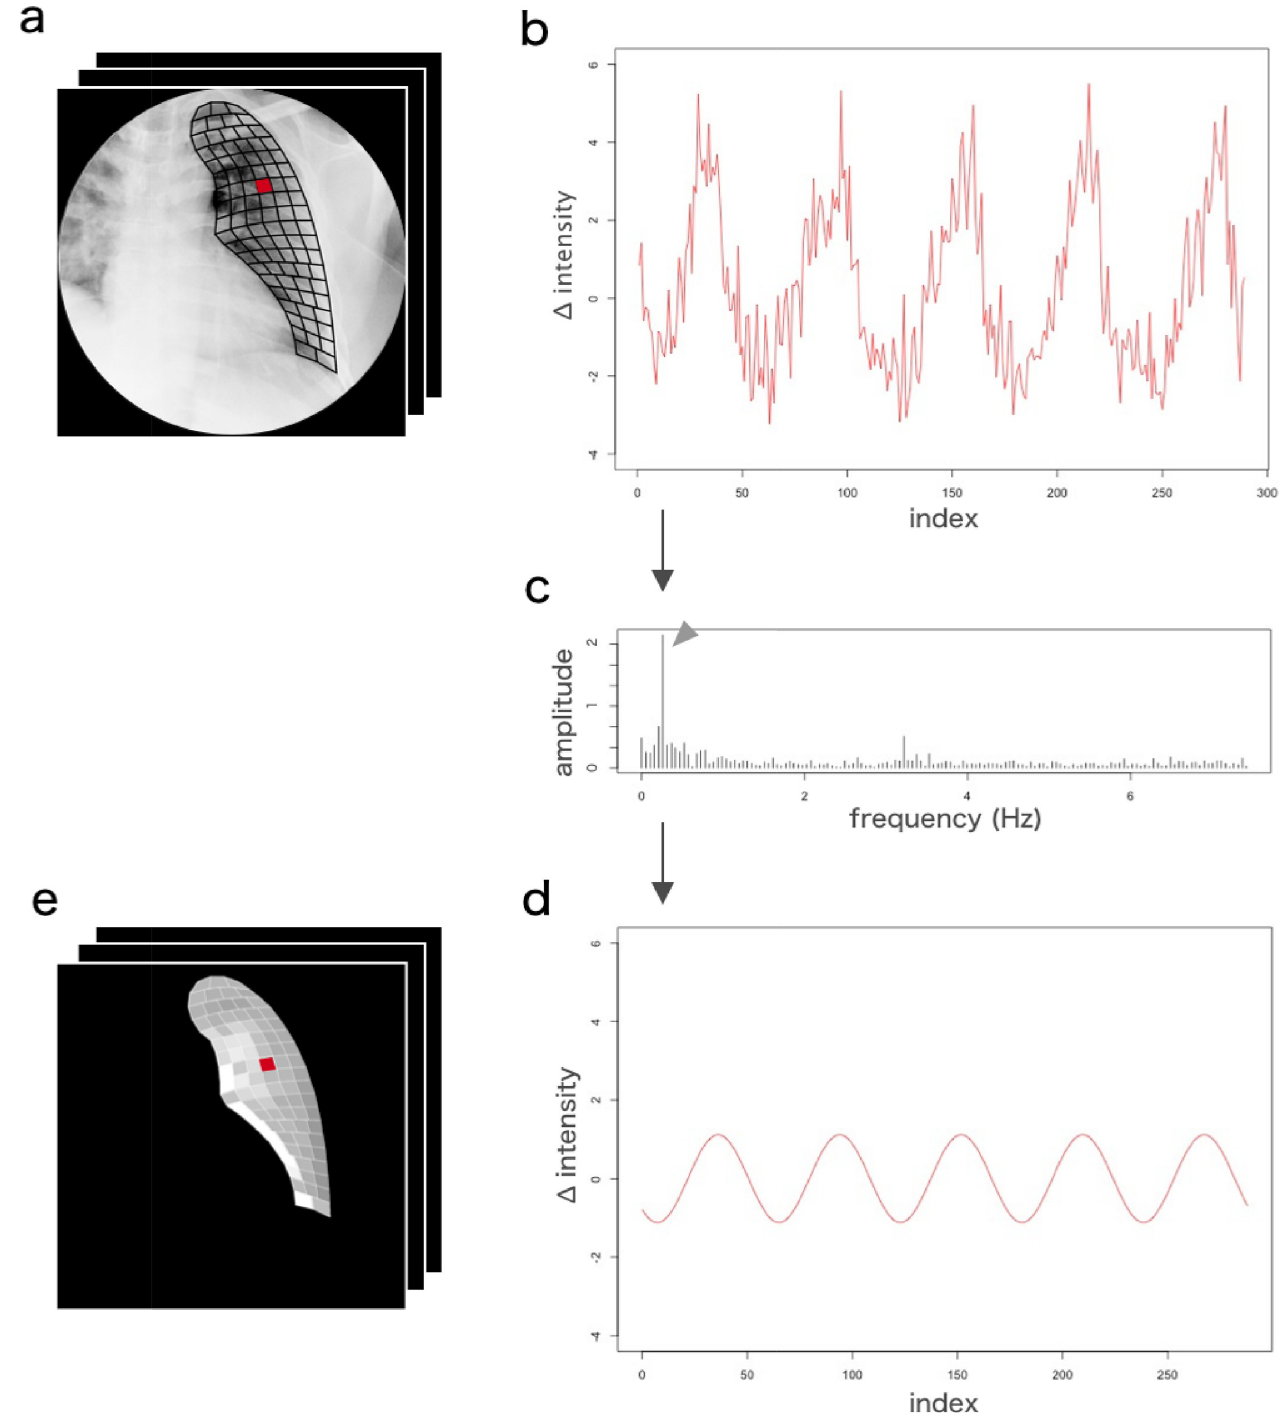
Fig 4. Outline of analysis using breath frequency-tuned dynamic images.